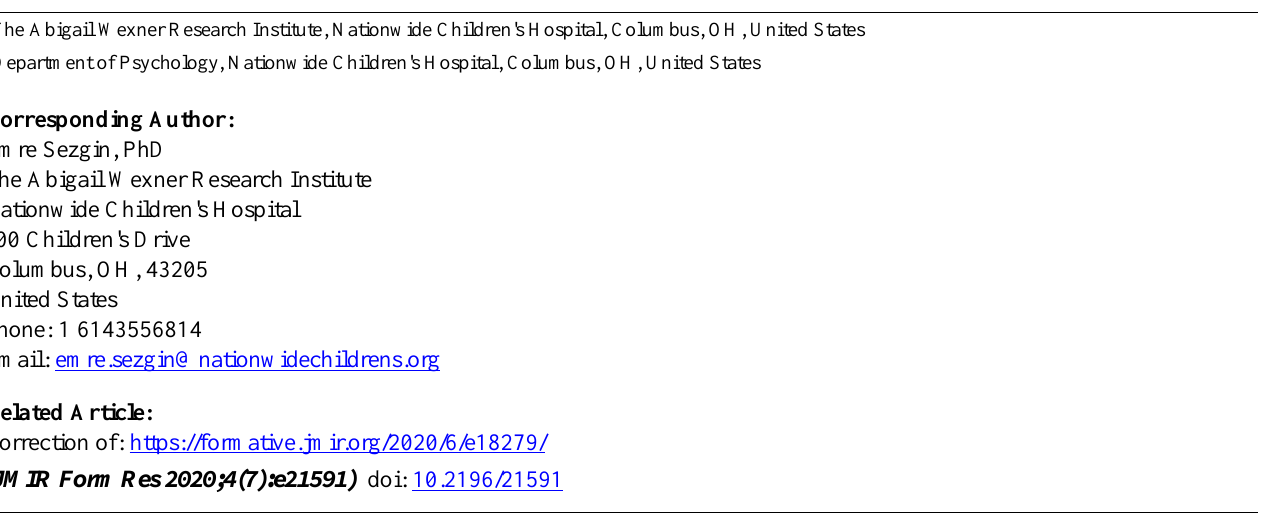
Figure 4 included an incorrect version of the ROC and Precision-Recall curves, which did not reflect the average precision (0.42) and AUC (0.95) reported in the manuscript. Figure 4 has been updated with the correct image and caption. Figure 4. Results on all Supernanny data. AUC: area under the curve; ROC: receiver operating characteristic.